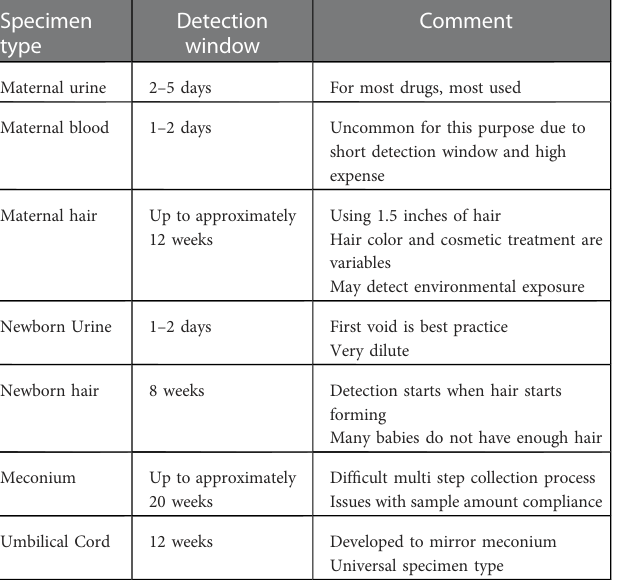
TABLE 3 Commonly accepted windows of detection by specimen